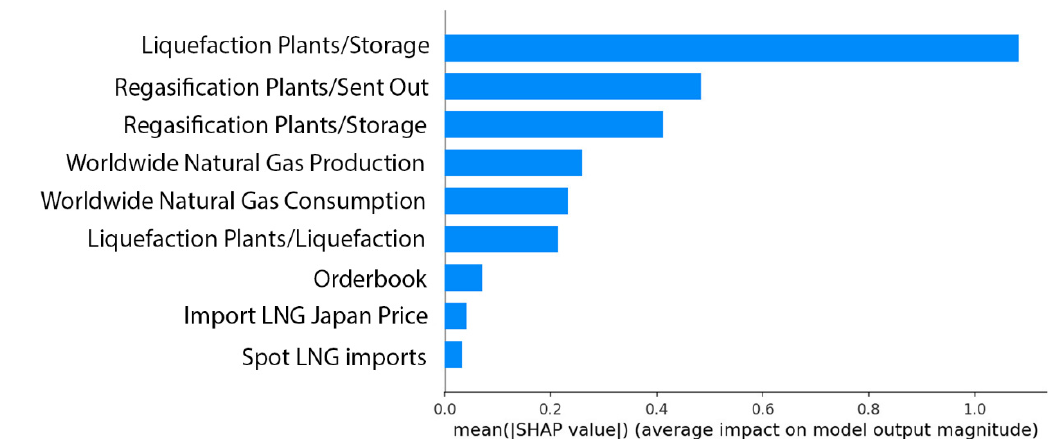
Figure 4. SHAP summary plot for LNG 145K CBM spot rate: 2 months of GFFN model.